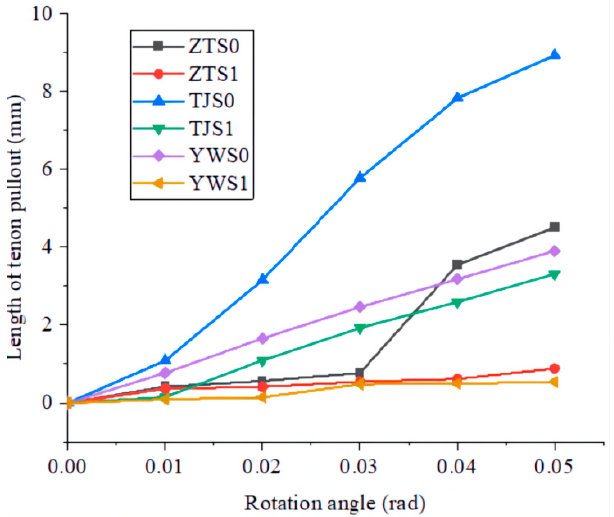
Figure 15. Relationship between tenon’s residual pulling amount and angle.